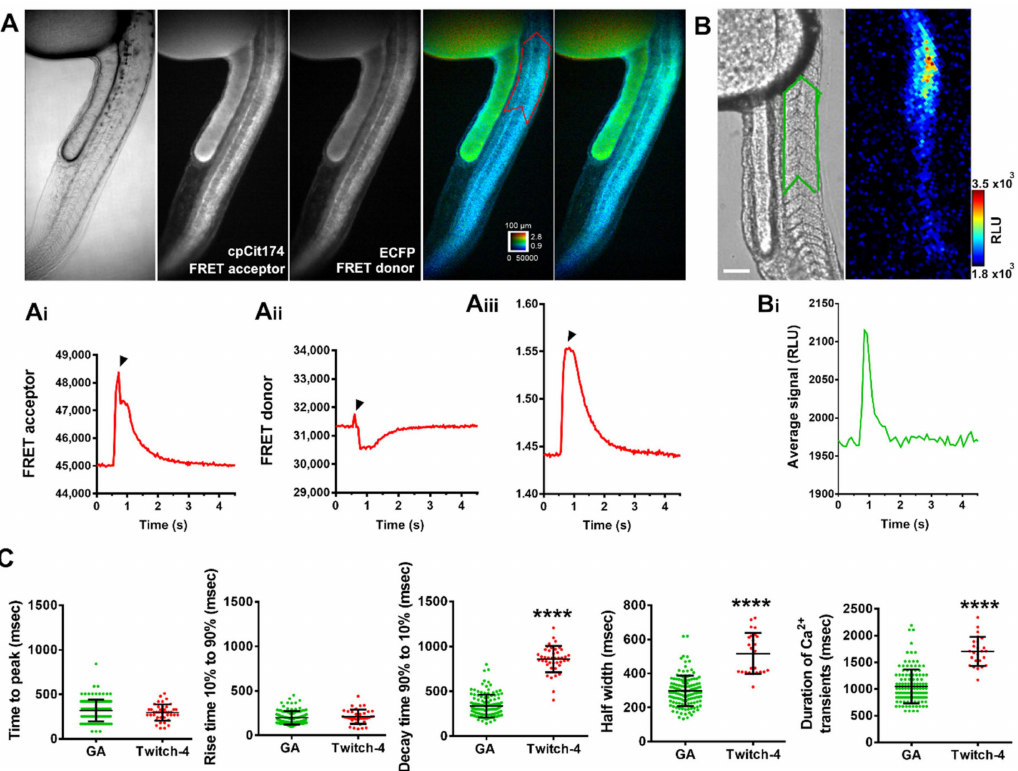
Figure 6. Kinetics of spontaneous Ca 2 + transients in the trunk and tail in 28 hpf zebrafish embryos. ( A ) Representative experiment of an embryo expressing Twitch-4, imaged at 33 Hz. Left panels, transmitted light image and fluorescence FRET and donor images (cpCit174 and ECFP, respectively). Right panels, emission ratio of Twitch-4 fluorescence (FRET acceptor / donor) in pseudocolor, at rest and during the peak of a Ca 2 + transient. The calibration square shows 100 µ m, hue codes for emission ratio, and intensity codes for fluorescence. A region of interest (ROI, red trace) comprising somites 6–11 was used for quantification of FRET channel fluorescence ( Ai ), donor channel fluorescence ( Aii ) and fluorescence emission ratio ( Aiii ) during the Ca 2 + transient. The black arrowheads indicate a motion artifact. ( B ) Transmitted light image and luminescence image during a Ca 2 + spike in a GA expressing embryo. A ROI (green trace) was used for quantification of bioluminescence. ( Bi ) shows the Ca 2 + transient measured in the ROI drawn in ( B ). The scale bar represents 100 µ m. The color scale indicates RLU. ( C ) Comparison of the kinetic parameters of cytoplasmic Ca 2 + transients measured with GA (bioluminescence imaged at 11.9 Hz, green points) and Twitch-4 (fluorescence acquired at 33 Hz, red points) in somites 6–11. A two-tailed unpaired t -test was used. Shown as mean ± S.D. ( n = 128 transients from 3 embryos for GA; n = 25 transients from 4 embryos for Twitch-4). Statistical significance was considered for **** p <